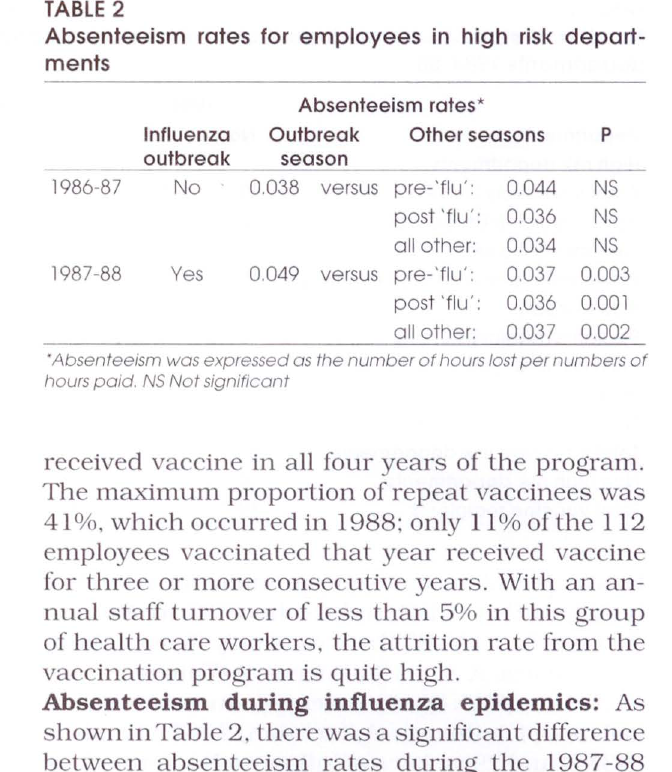
Absenteeism rates for employees in high risk depart